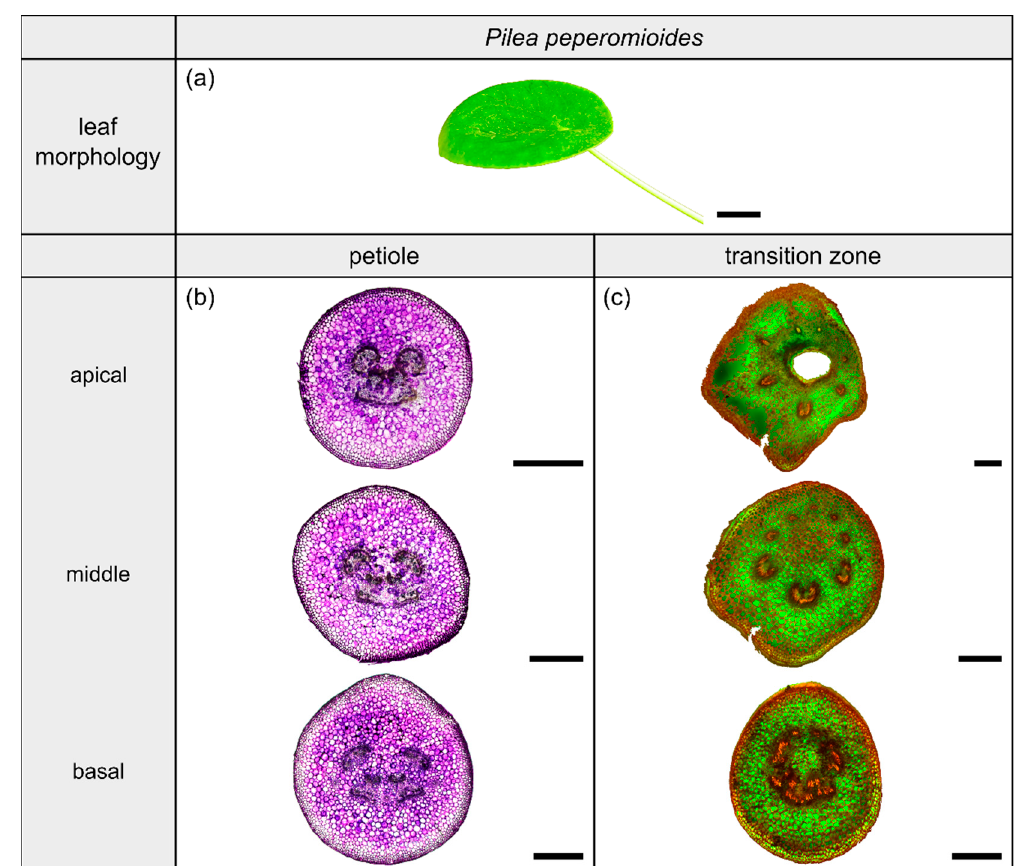
Figure 6. Morphology and anatomy of the foliage leaf of Pilea peperomioides ( a ). The thin-sections of the transition zone are stained with acridine orange ( c ) and those of the petiole are stained with toluidine blue ( b ). The scale bar of the leaf morphology equals 2 cm and those of the anatomical sections equal 1 mm.